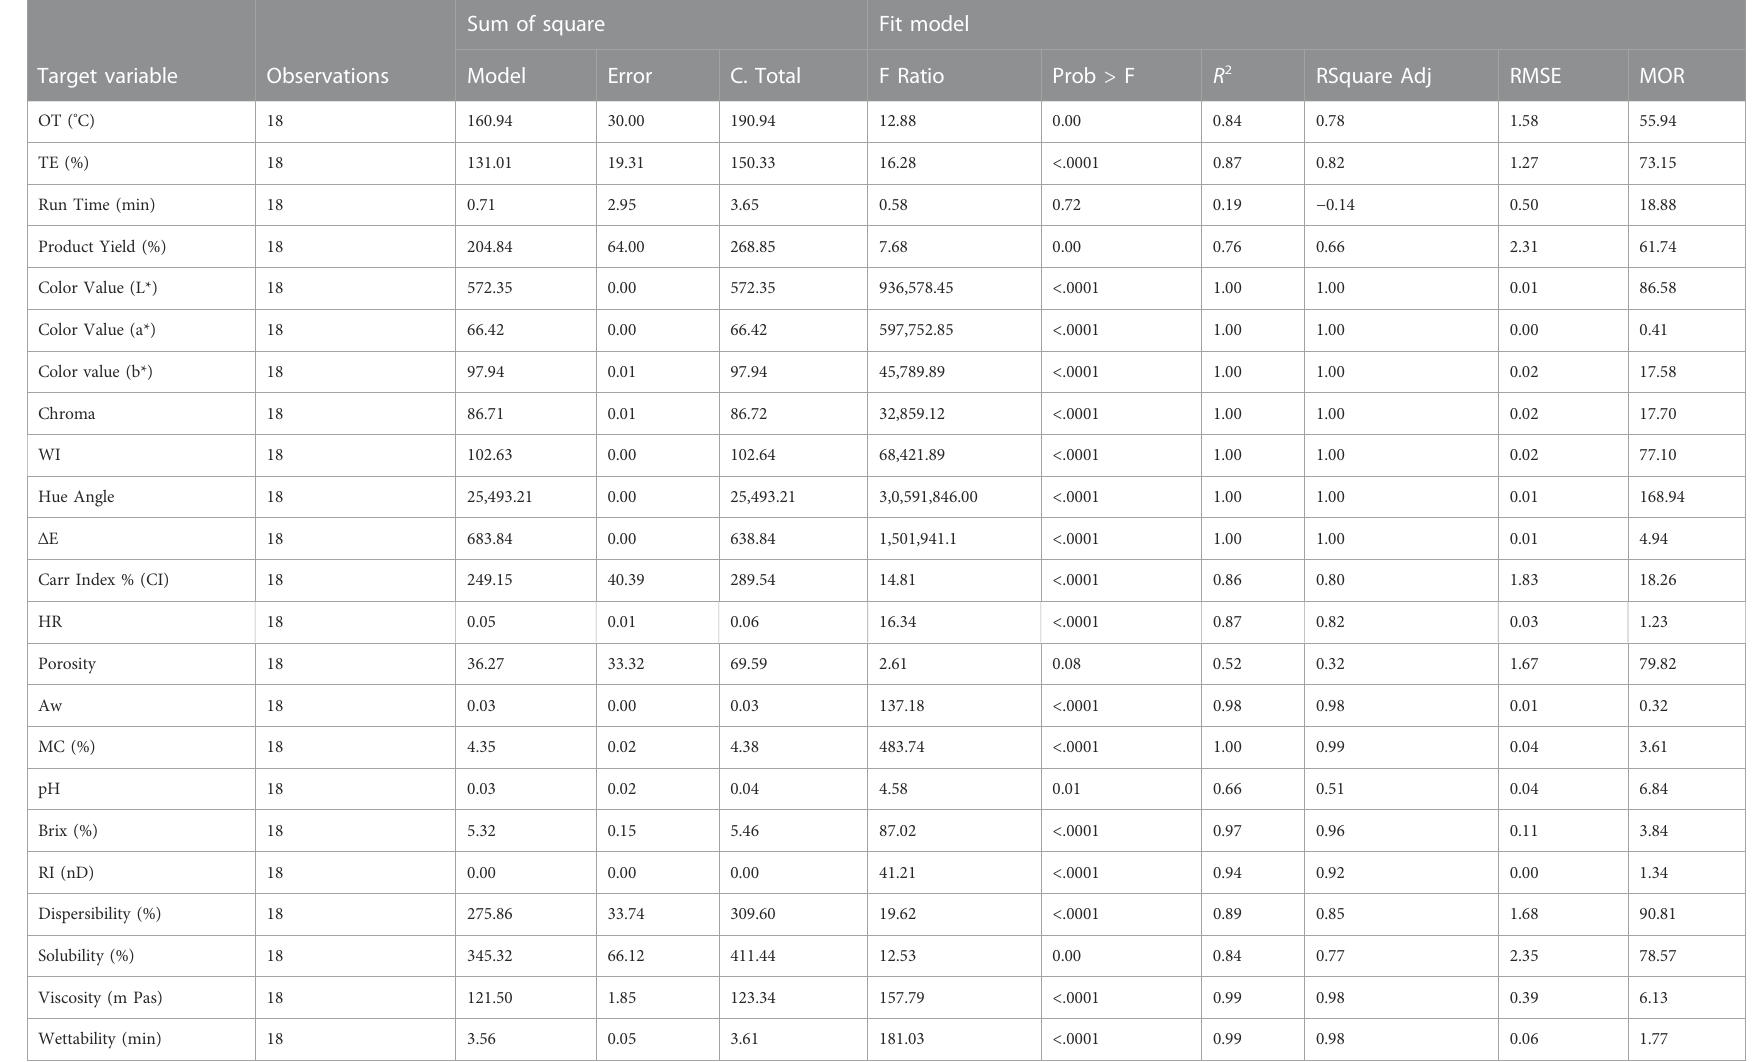
TABLE 3 Analysis of variance (ANOVA) table for full factorial design showing factors and their effect on